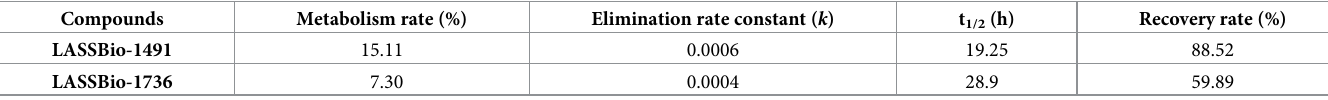
Table 3. Pharmacokinetic parameters determined from the in vitro plasma stability studies of LASSBio-1491 and its isostere LASSBio-1736. Compounds